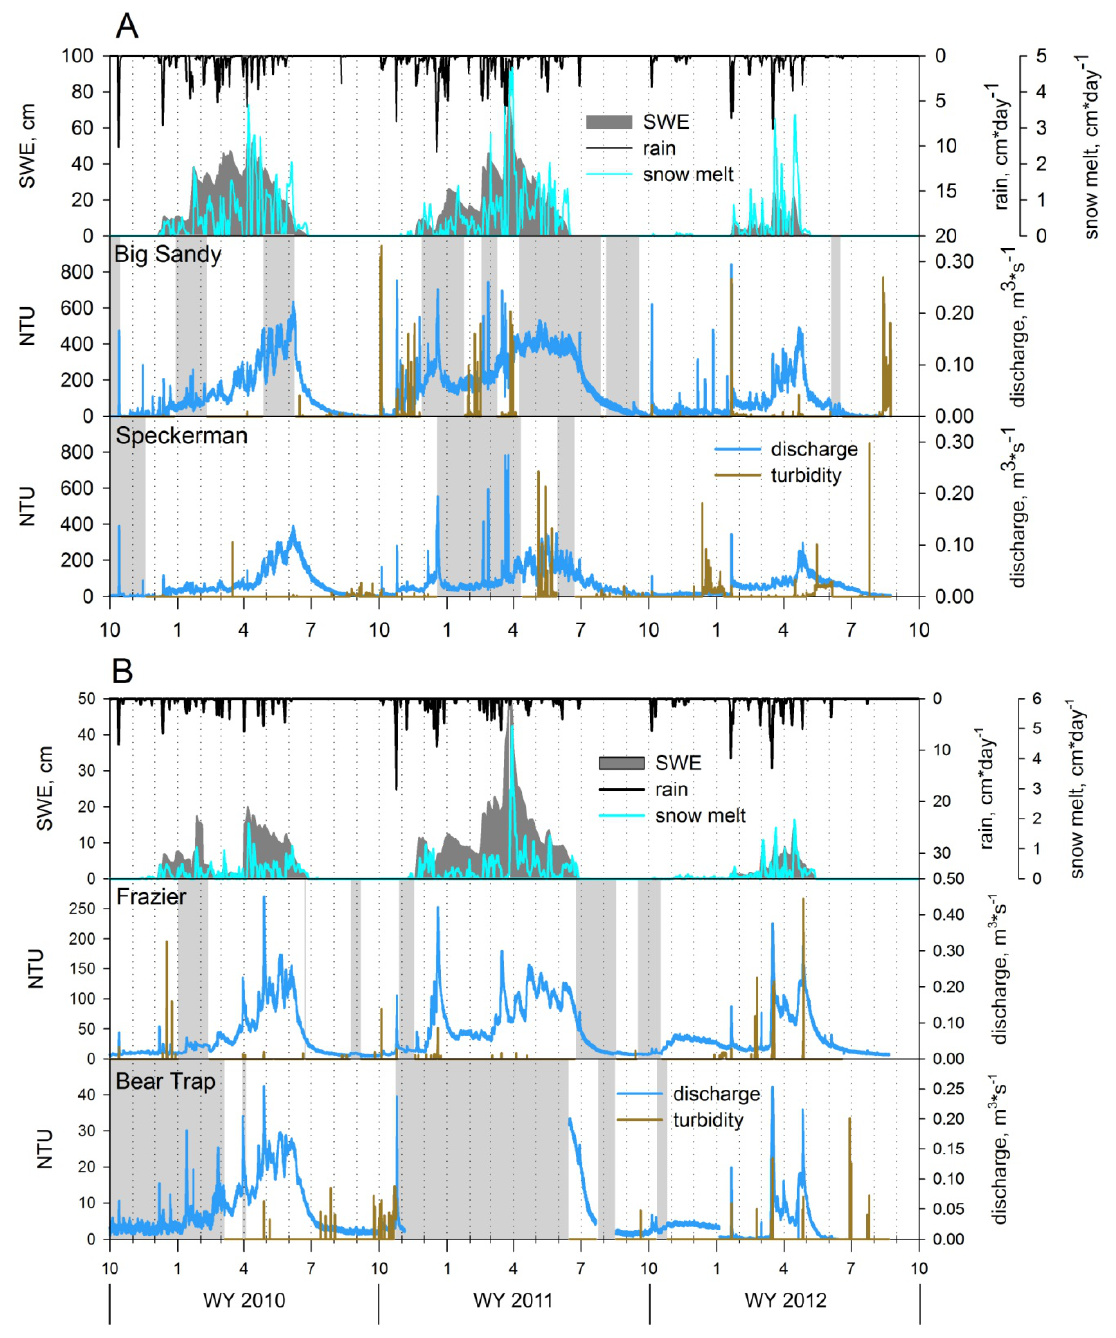
Figure 2. Precipitation, discharge, and turbidity data for ( A ) Sugar Pine and ( B ) Last Chance sites for WY 2010–WY 2012. Snow values are averaged across the study area. The light grey shaded areas indicate periods when turbidity data were not